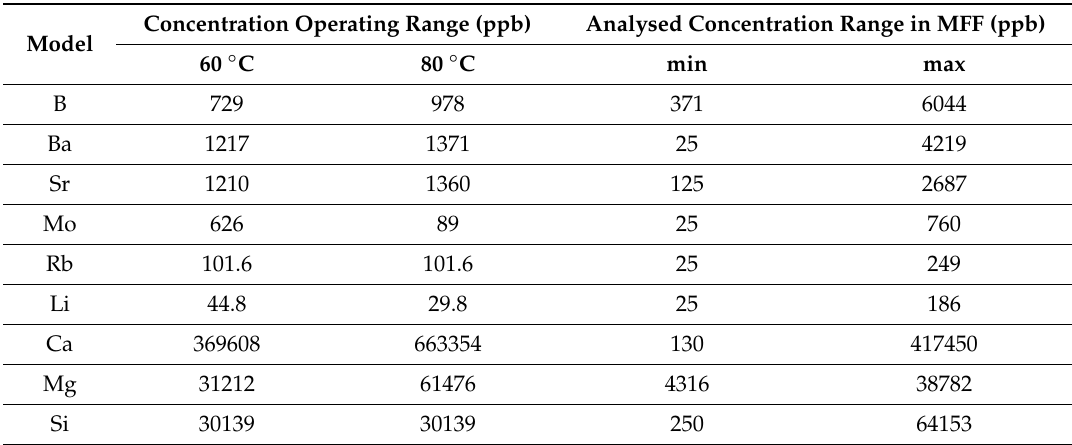
Table 14. Possible range of selected elements decreased in flowback